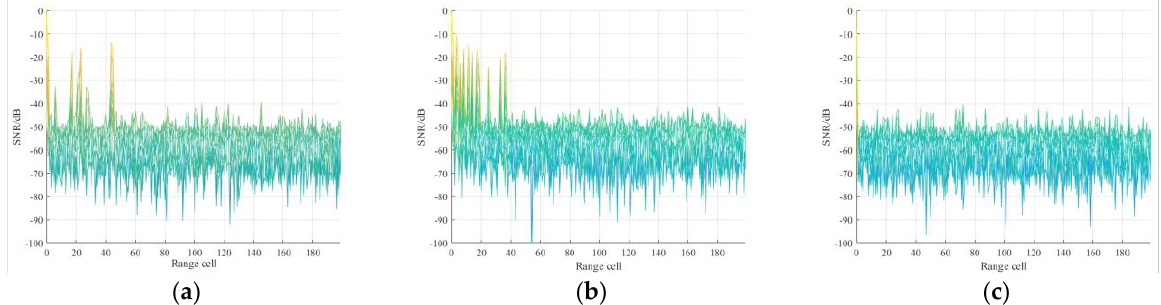
Figure 6. Autocorrelation results of reference signal in different channel model: ( a ) reference signal in Brazil A; ( b ) reference signal in COST207; ( c ) ideal reference signal.